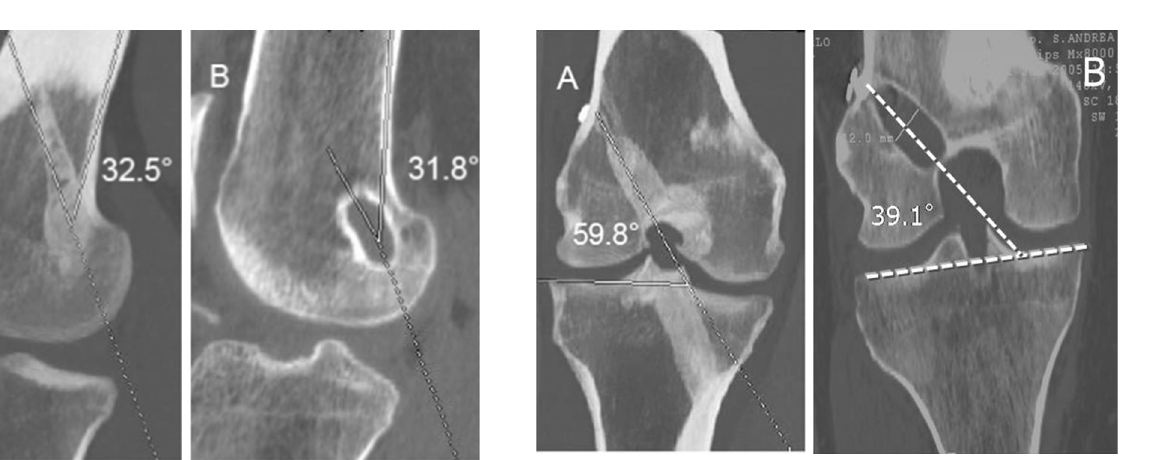
Fig. 2 The coronal obliquity is shown on these CT images. A line parallel to the joint line and the femoral tunnel was used to calculate the coronal obliquity. In this case the value is 59.8 (cid:3) for the in–out group ( a ) and 39.1 (cid:3) for the out–in group ( b )